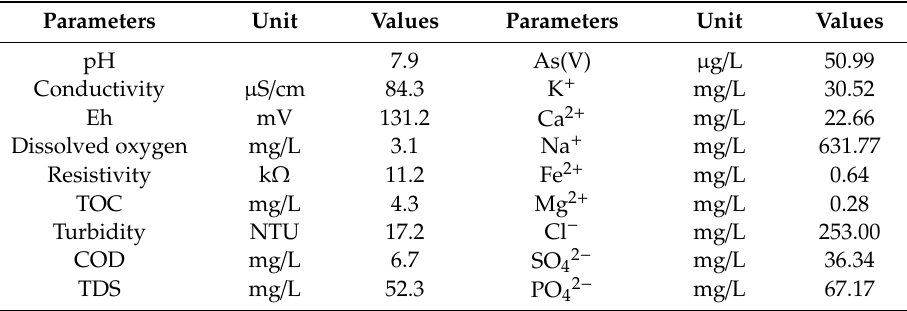
Table 1. Natural groundwater characteristics obtained from